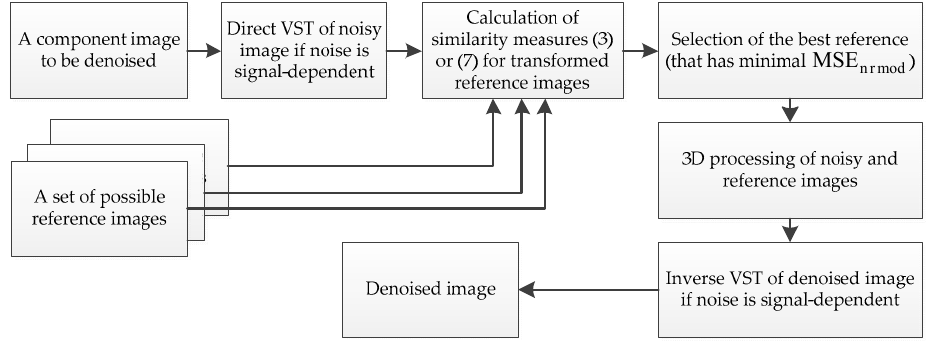
Figure 3. Block-diagram of the proposed processing approach. VST—variance stabilizing transform; MSE—mean square error.